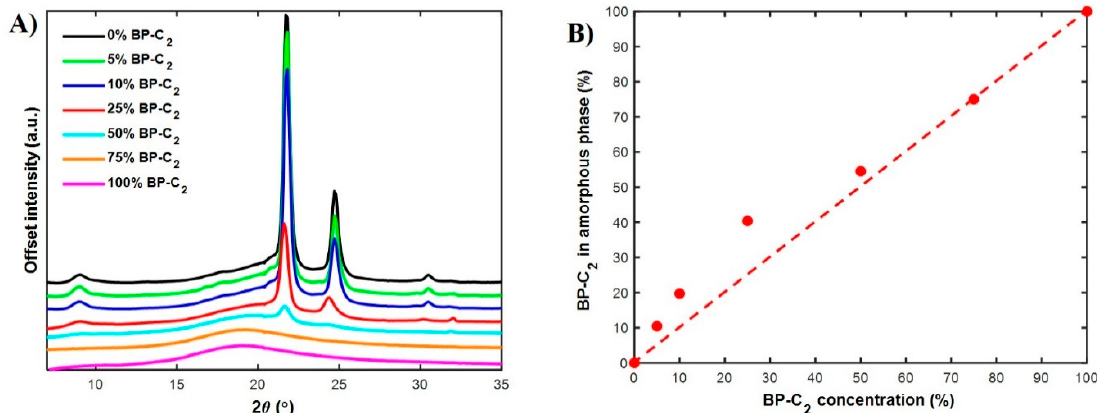
Figure 5. (A ) WAXD diffraction patterns of the polymers synthesized in this study, and ( B ) percentage of BP-C 2 in the amorphous phase compared to sebacic acid.